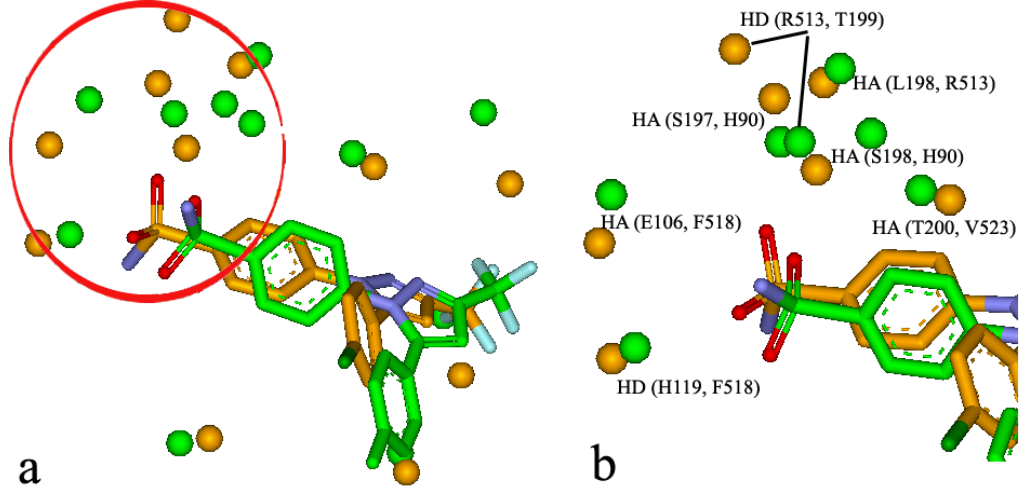
Figure 7. ( a ) The similar site of CAII (in green, PDB entry: 1OQ5) and that of COX-2 (in orange, PDB entry: 6COX); ( b ) the similar subsite of CAII and COX-2 taken from.